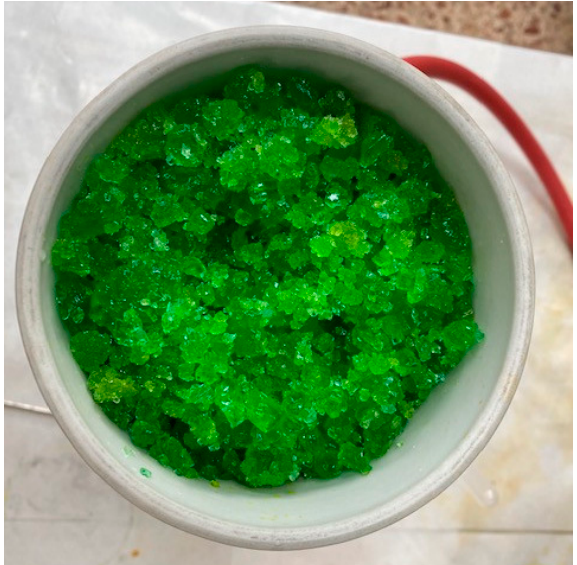
Figure 1. Ferrous chloride crystals obtained from water pickling liquors by the described method.